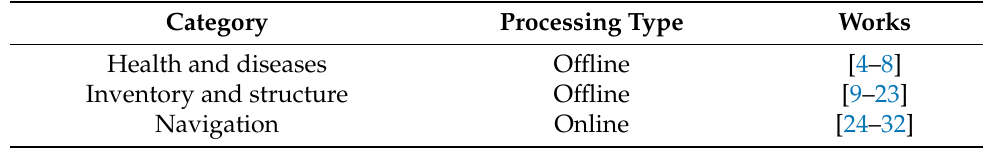
Table 1. Summary of the collect works about vision-based